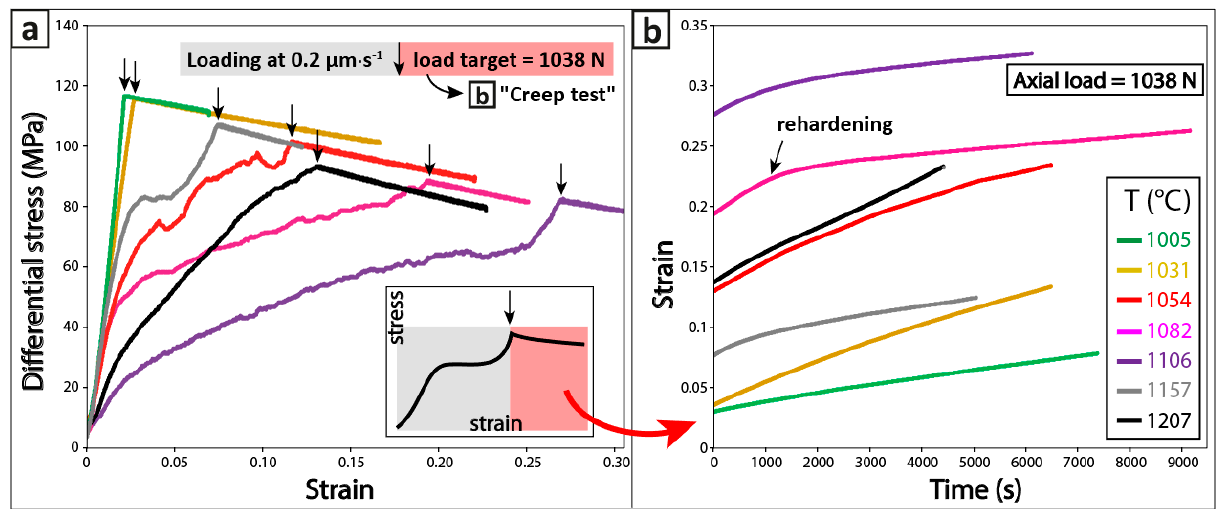
Figure 6. Set of experiments for a loading rate of 0.2 µm·s –1 up to 1038 N. ( a ) Stress as a function of axial strain during the loading step (grey shade) and the creep test (red shade), for temperatures between 1005 and 1207 °C; ( b ) Strain as a function of time at a constant load of 1038 N. Vertical arrows on ( a ) account for the load target, i.e., beginning of the “creep test” ( b ).